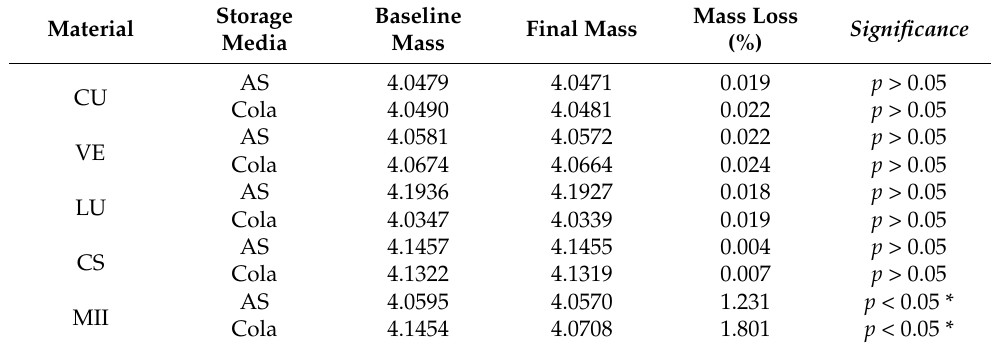
Table 3. Percent mass loss of the antagonist against the tested CAD/CAM